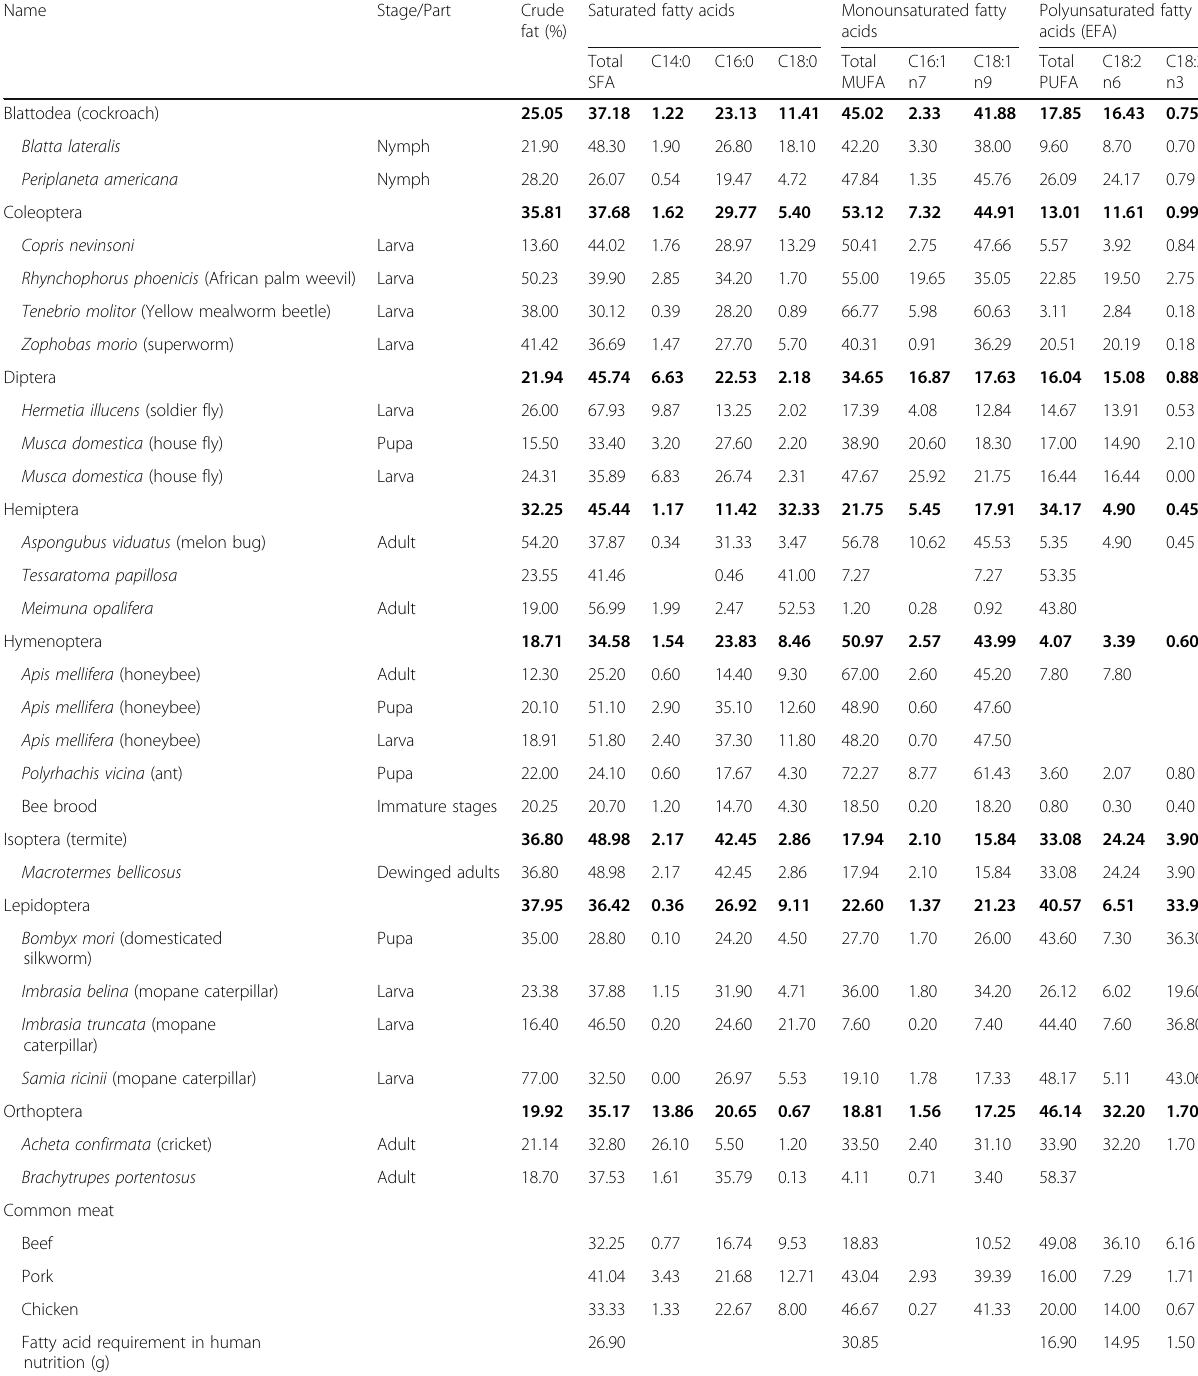
Table 2 Fat content (%) of common edible insects (% in crude fat of dry